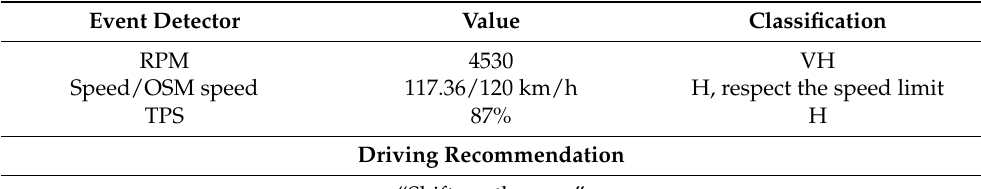
Table 6. Driving feedback for a sample of the studied track (H: high, VH: very high) .